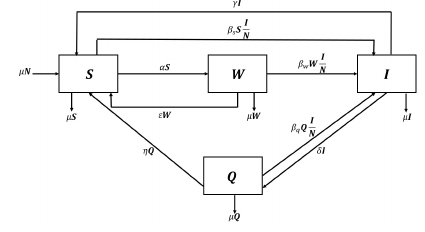
Figure 2. The transfer diagram of model